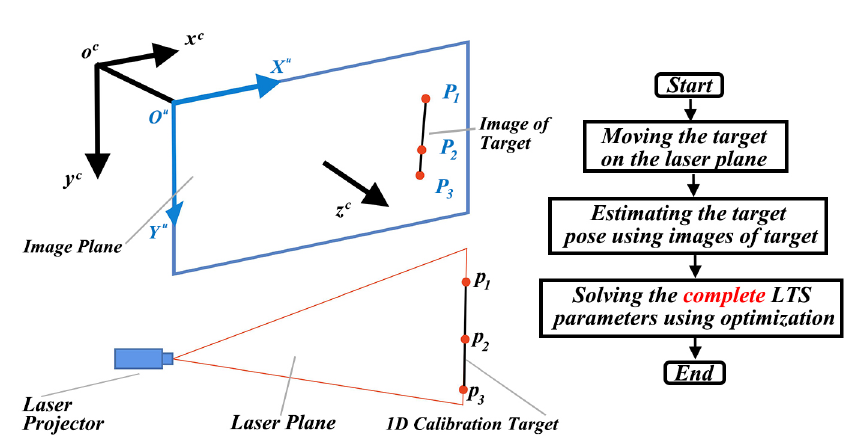
Figure 1. The schematic of the proposed laser triangulation sensors (LTS) calibration method. To calculate the position of the target, a 2D local coordinate system o c x t y t is established on the 2D plane that is spanned by the camera optical center o c and the 1D target shown in Figure 2. In Figure 2, the line connecting o c and p 1 is set as the x axis of o c x t y t . The line connecting o c and p 2 ( x 2 , y 2 ) is denoted as l 2 . The line connecting o c and p 3 ( x 3 , y 3 ) is denoted as l 3 . The slopes of l 2 and l 3 are denoted as k 2 and k 3 , respectively.